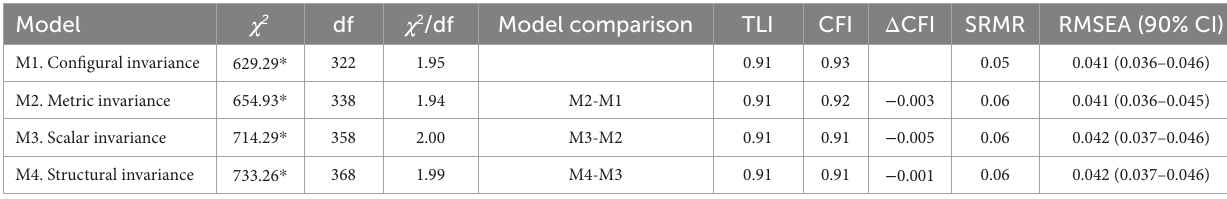
TABLE 3 Testing for factorial invariance of ARS_MCV across gender ( n =